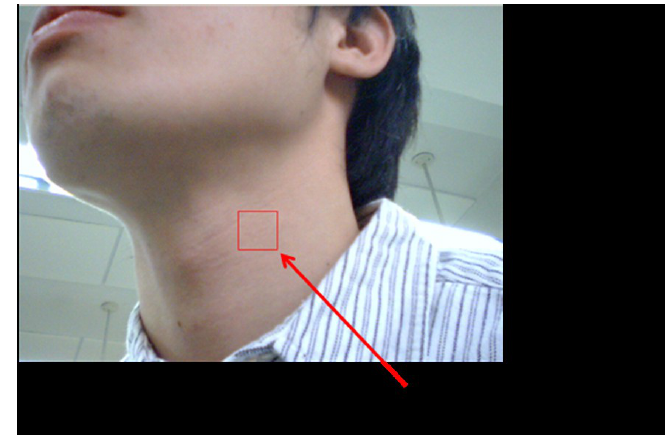
Figure 17. The experimental setup for measuring the neck arterial pressure signal via a webcam and the finger blood-oxygen saturation level.